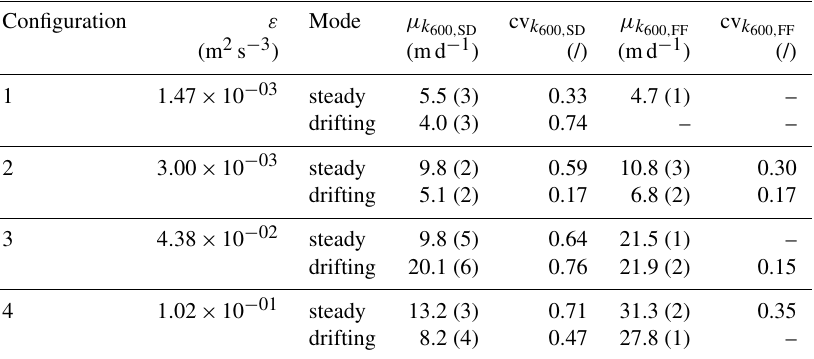
Table 3. Summary of ε , the mean and the coefficients of variation of the standardized gas exchange velocities, k 600 , observed during the different configurations in anchored and drifting deployments both for the standard (SD) and flexible foil (FF) chambers. The number between brackets in the column of the mean value indicates the number of